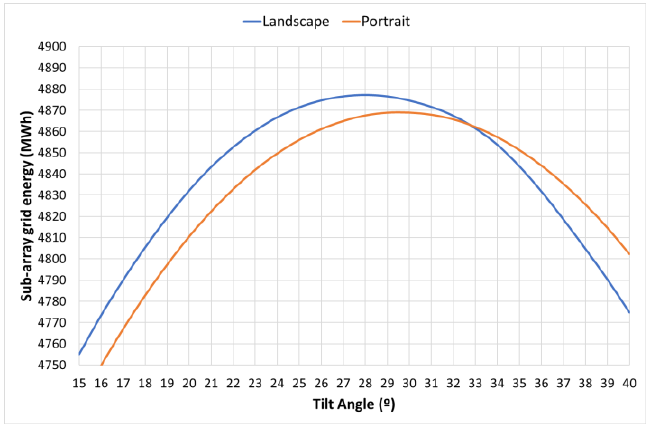
Figure 3. Sub-array grid injected energy as a function of tilt; portrait versus landscape; central inverter; pitch=9.65 m.